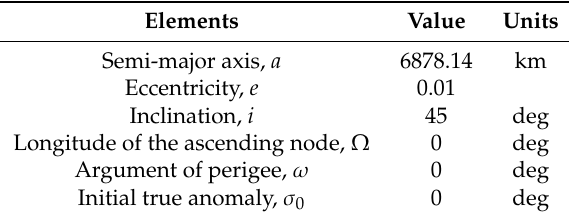
Table 4. Orbit elements of the target spacecraft.